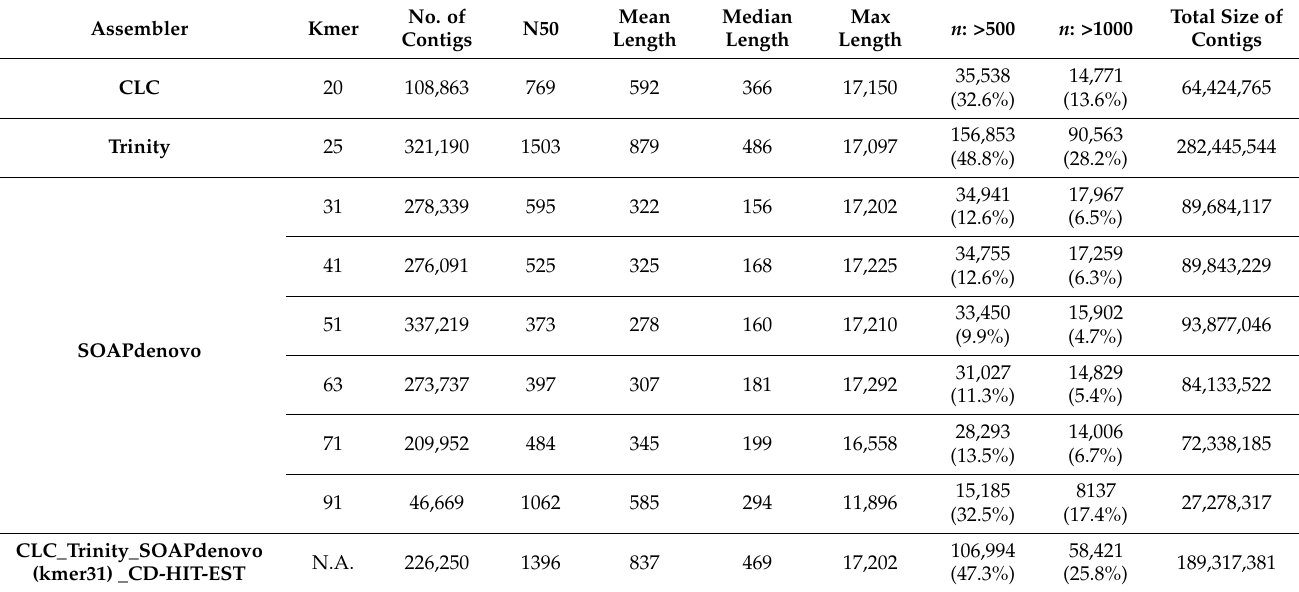
Table 1. Assembly statistics for Mallotus japonicus de novo transcriptome assembly based on three popular assemblers and their